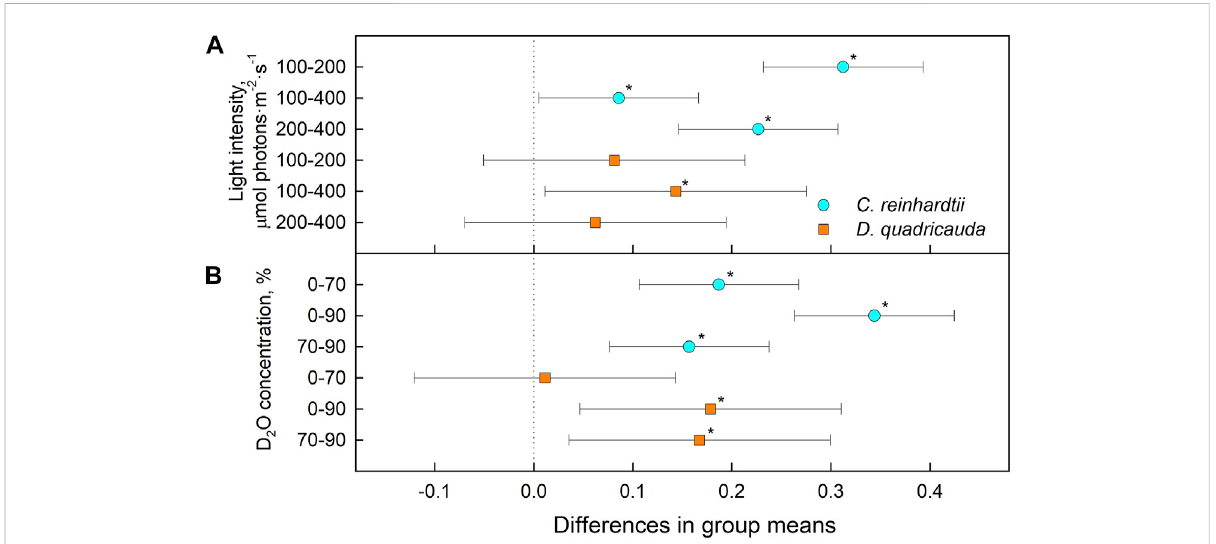
FIGURE 14 Tukey ’ s HSD test of singlet oxygen levels plotted as 95% con fi dence intervals of mean differences between groups indicated on the left. The effect of lightintensity (A) and theeffect of D 2 O concentration (B) on singlet oxygen levelsin C. reinhardtii (cyan circles) and D. quadricauda (orange squares) are shown separately. A difference in group means (X axis) equal to zero indicates that the group means are equal, so only a con fi dence interval that does not contain zero is statistically signi fi cant ( p = 0.05, indicated by an